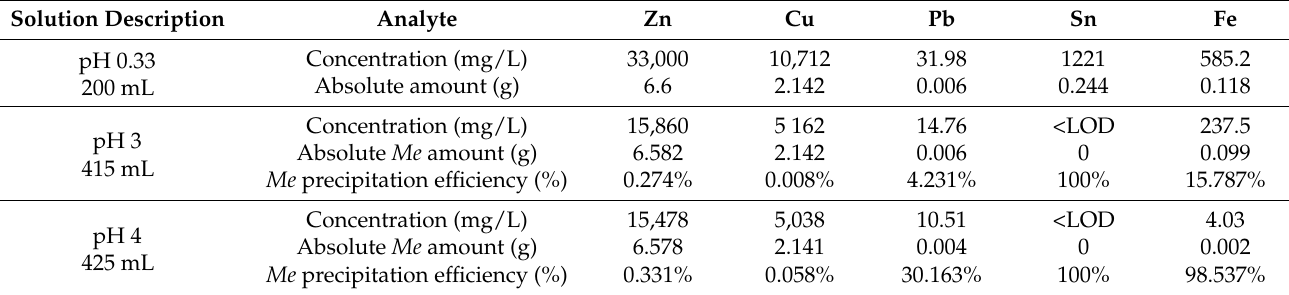
Figure 10. Products obtained by pH adjustment and filtration: ( a ) solution with pH adjusted to 3, ( b ) precipitate from pH adjustment to 3, ( c ) solution with pH 3 after filtration, ( d ) solution with pH adjusted to 4, ( e ) precipitate from pH adjustment to 4, ( f ) solution with pH 4 after filtration. Table 5. Chemical analysis of solution before and after refining by pH